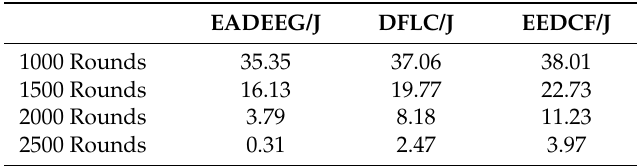
Table 7. System residual energy in Scenario 2.